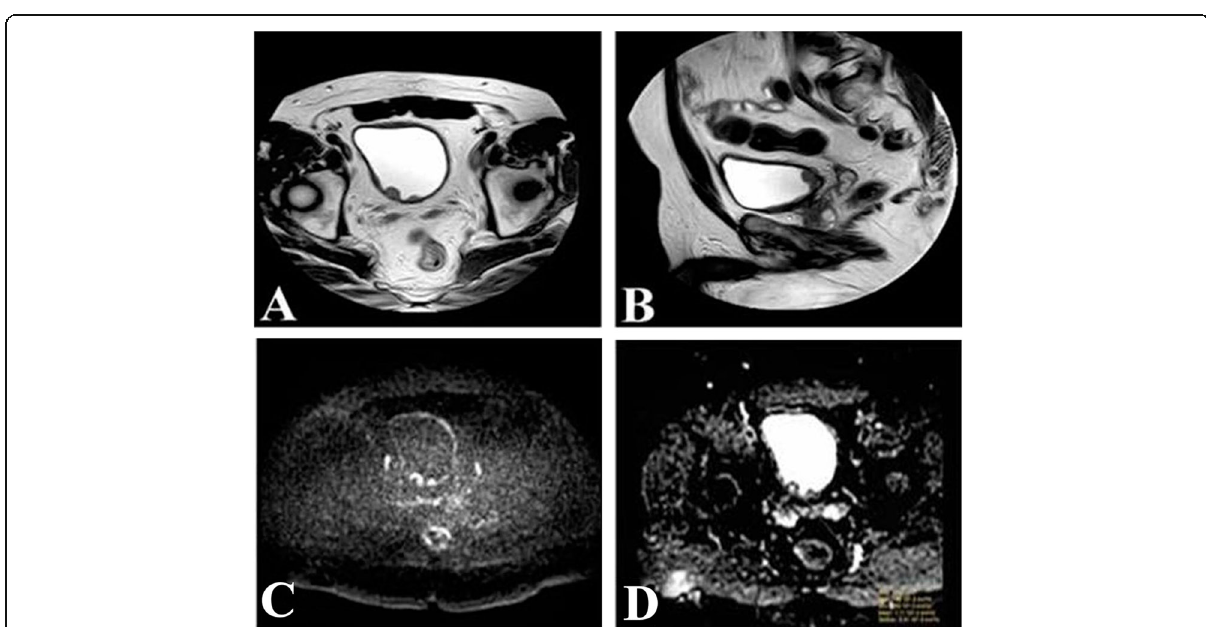
Fig. 2 Multiple nodular growths are seen arising from posterior and right lateral wall with no evidence of abnormal signals in overlying muscle layer. a Axial HR T2 image, b sagittal HR T2 image, c axial DWI image (b 1400), and d ADC map with ADC measured within lesion (1.1 × 10 − 3